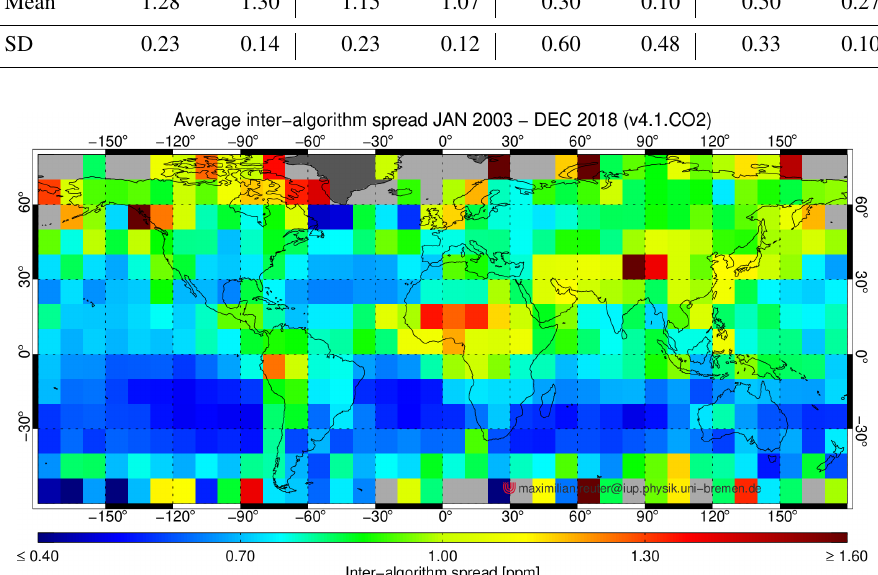
Figure 11. Average XCO 2 inter-algorithm spread (1 σ ) during 2003–2018. As can be seen, the scatter is typically around 1ppm except over parts of the tropics (in particular central Africa), the Himalayas, and at high latitudes, where the scatter can be